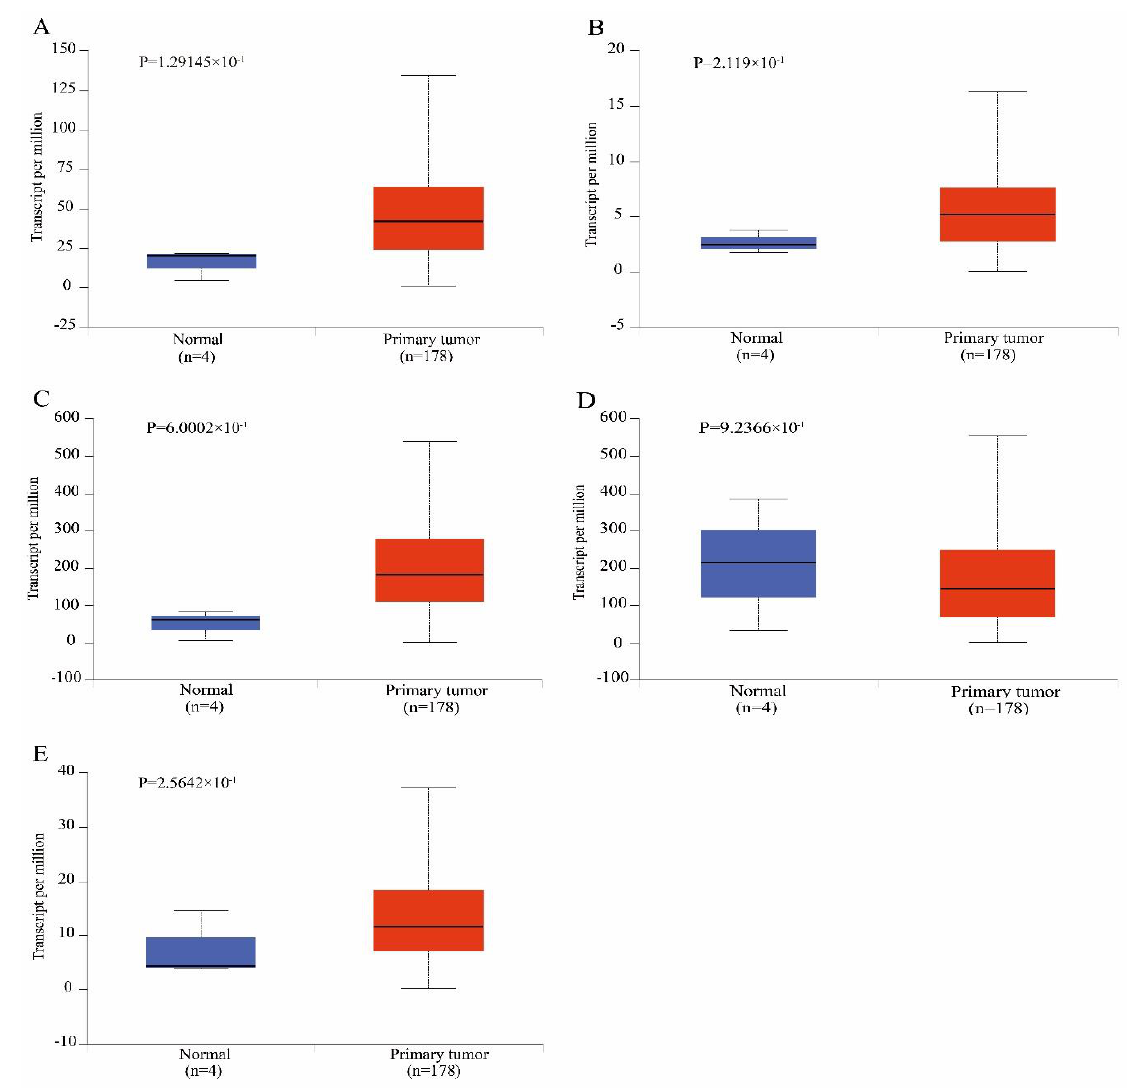
Figure 4. Box-whisker plots showing the expression of hub genes in pancreatic adenocarcinoma samples. ( A ) Proto-oncogene receptor tyrosine kinase Met ; ( B ) Maternal embryonic leucine zipper kinase ; ( C ) syndecan 1 ; ( D ) thrombospondin 1 ; ( E ) DNA topoisomerase II alpha .